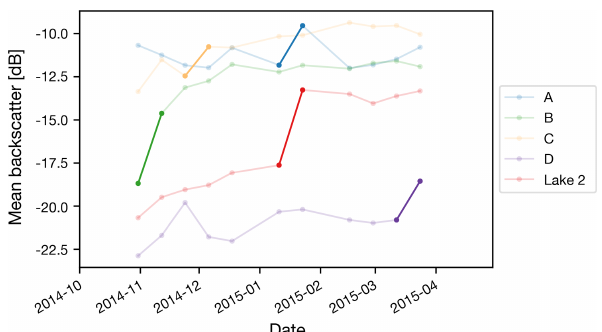
Figure 2. This figure illustrates the filtering criteria for identifying drained lakes. (A) Anomalous sustained step change but one that is not sustained. (B) Anomalous increase but with insufficient history to determine if the change was an adjustment from a previous dip or step increase from a previous low. (C) Anomalous sustained change but with a prior dip such that this change was a return to prior val- ues rather than a sustained change. (D) Anomalous change without sufficient information to confirm a sustained change. Lake 2 shows anomalous, sudden and sustained backscatter change depicting lake drainage. All the time series shown are results from actual lakes in the 2014/15 season. Bold line segments are the transitions that met the z -score